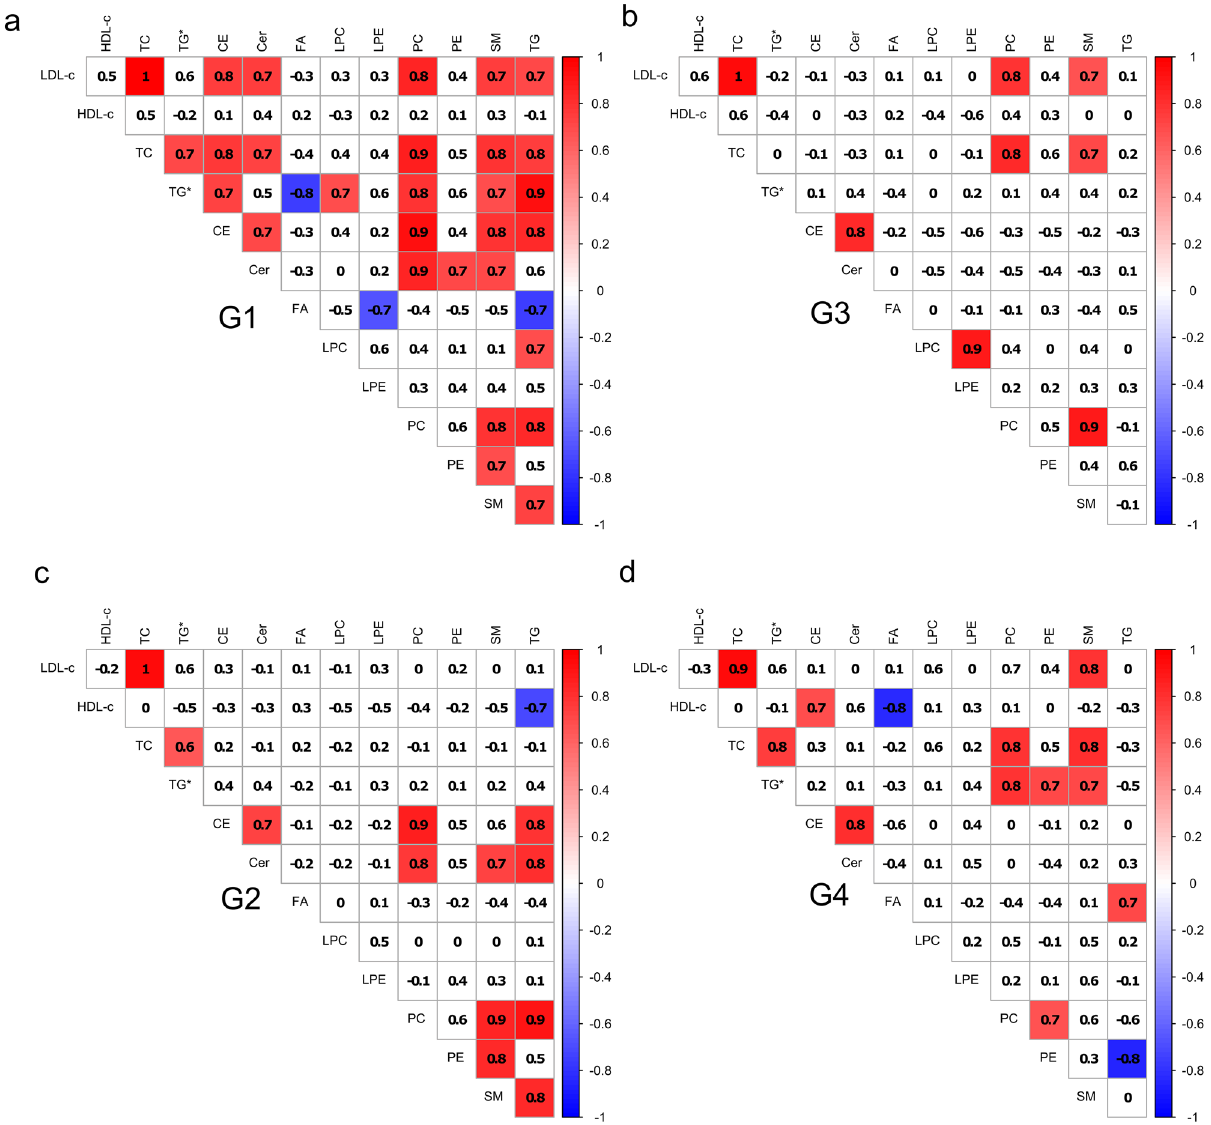
Figure 3. Pearson’s correlation of lipid classes concentrations and clinical parameters. ( a ) for rosuvastatin treatment at D1 (G1), ( b ) for simvastatin plus ezetimibe treatment at D1 (G3), ( c ) for rosuvastatin treatment (G2) at D30, and ( d ) for simvastatin plus ezetimibe treatment at D30 (G4). Figure was created in R 3.6.3 (The R Project for Statistical Computing; https:// www.r- proje ct. org/ packa ges: corrplot, Hmisc, RColorBrewer,